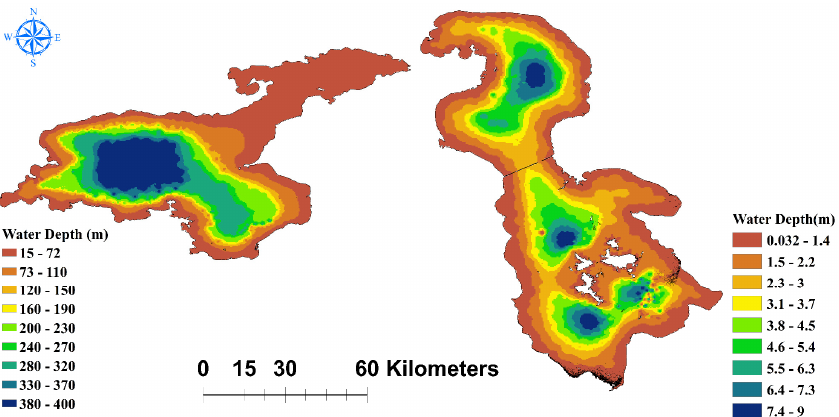
Figure 12. Bathymetric maps of LU ( right ) and LV ( left ) in 2000.